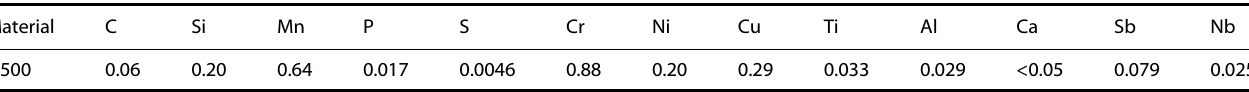
Table 1. The composition of low-alloy steel Q500.